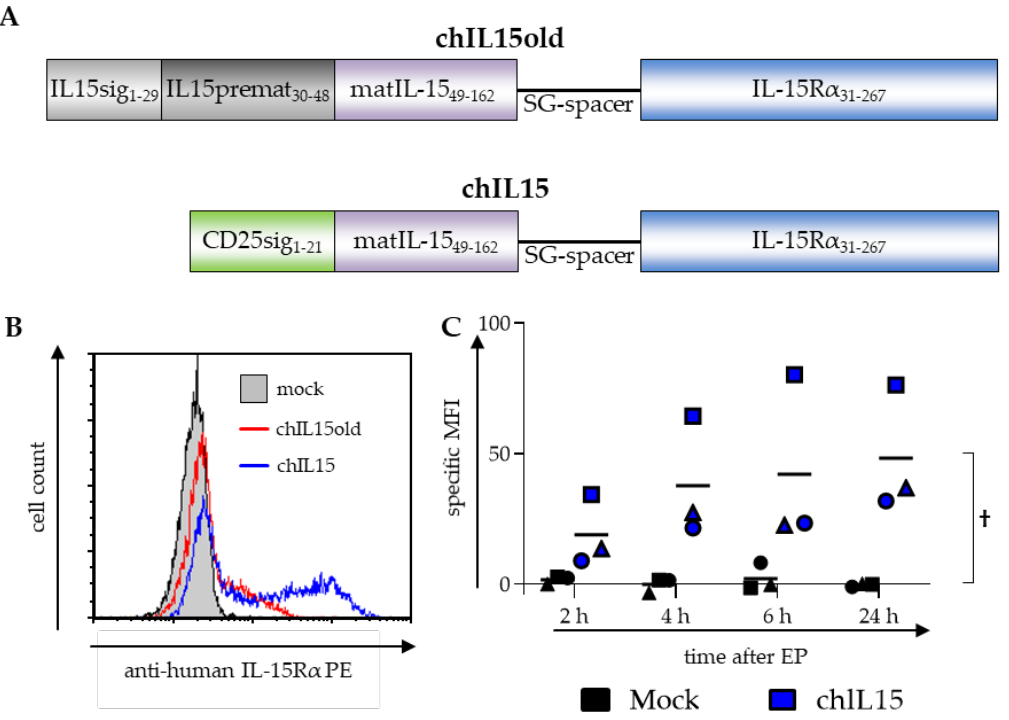
Figure 1. Composition and expression of the chimeric IL15 constructs. ( A ) Originally, the protein sequence of the complete IL-15 transcript variant 1 was fused to that of the IL- 15Rα via a flexible SG -linker (SG 3 (SG 4 ) 3 SG 3 S). This construct is referred to as chIL15old. To improve the construct, the first 48 AA of the IL-15 transcript variant 1 that constitute the signal peptide and the pro-peptide were replaced with the signal sequence of CD25. The signal sequence of the IL- 15Rα was removed so that the linker was directly fused to the first sushi-domain. This altered construct is referred to as chIL15. ( B ) To measure the expression of the chIL15old and the chIL15 construct on the surface of DCs, cytokine matured DCs were electroporated with mRNA encoding the chIL15old (red line) or chIL15 (blue line), or as a negative control were mock electroporated (grey histogram). The cells were stained with an IL- 15Rα -specific antibody and analyzed by flow cytometry. A histogram of DCs electroporated with chIL15old, chIL15, or without RNA (mock) and stained for IL- 15Rα 24 h after electroporatio n is shown ( n =3 for chIL15, n =1 for chIL15old). ( C ) The expression kinetics of chIL15 was determined 2, 4, 6, and 24 h after electroporation. The specific mean fluorescence intensity (MFI) was calculated by subtracting the isotype control MFI from the MFI measured with the IL- 15Rα -specific antibody (different symbols represent the three individual experiments). The interaction p -value between the mock and the chIL15 condition was calculated by two- way ANOVA, † p ≤ 0.05 .